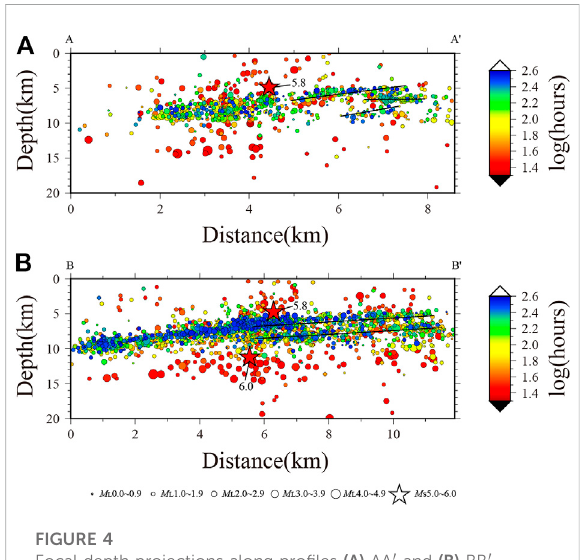
FIGURE 4 Focal depth projections along pro fi les (A) AA ′ and (B) BB ′